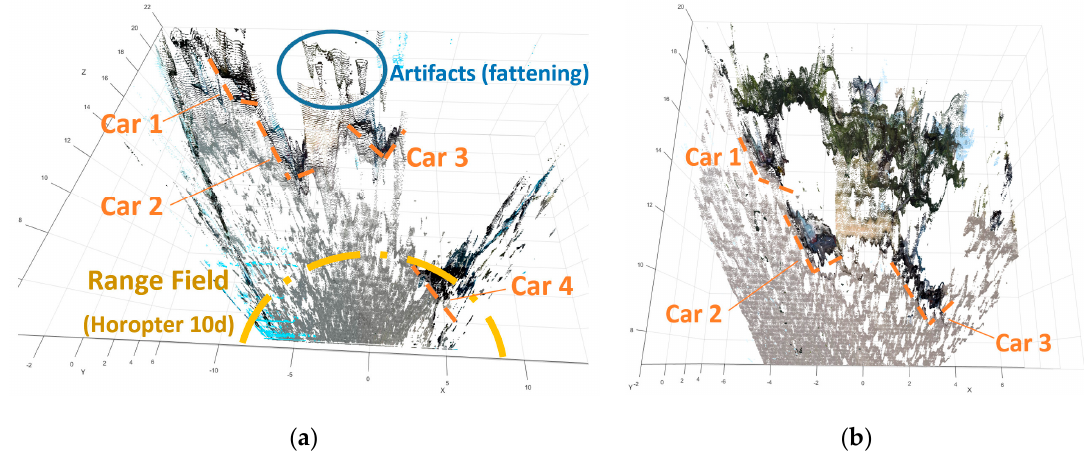
Figure 10. Top view of the 3D point clouds corresponding to the turning maneuver. ( a ) Depth measurement delivered by the short range sensor (accurate depth measures are inside the Range Field); ( b ) Depth measures delivered by the long range sensor (Car 4 is not in the common Field of View of this stereo camera sensor).